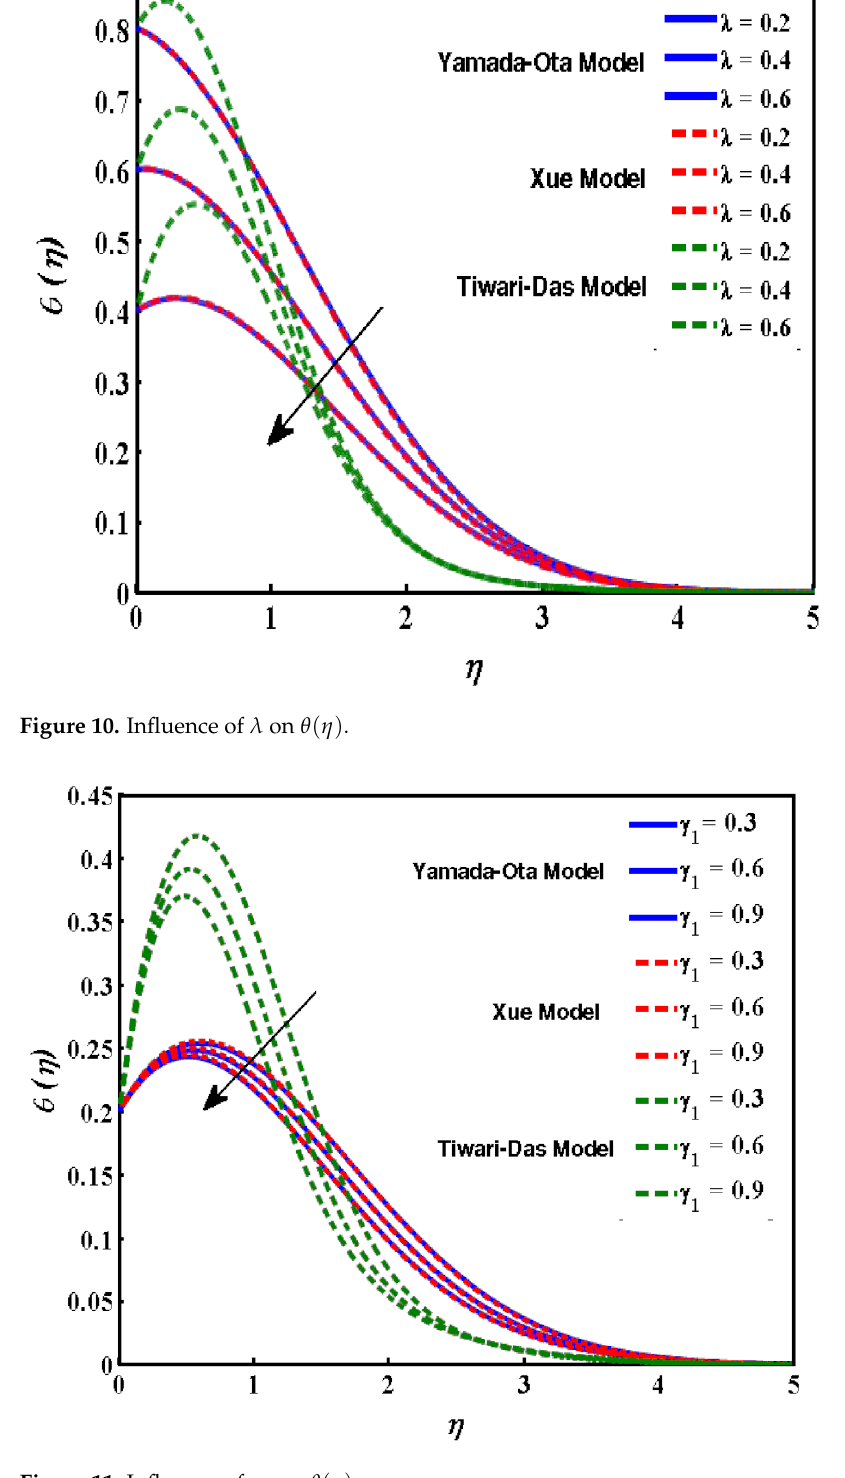
Figure 11. Influence of γ 1 on θ ( η )